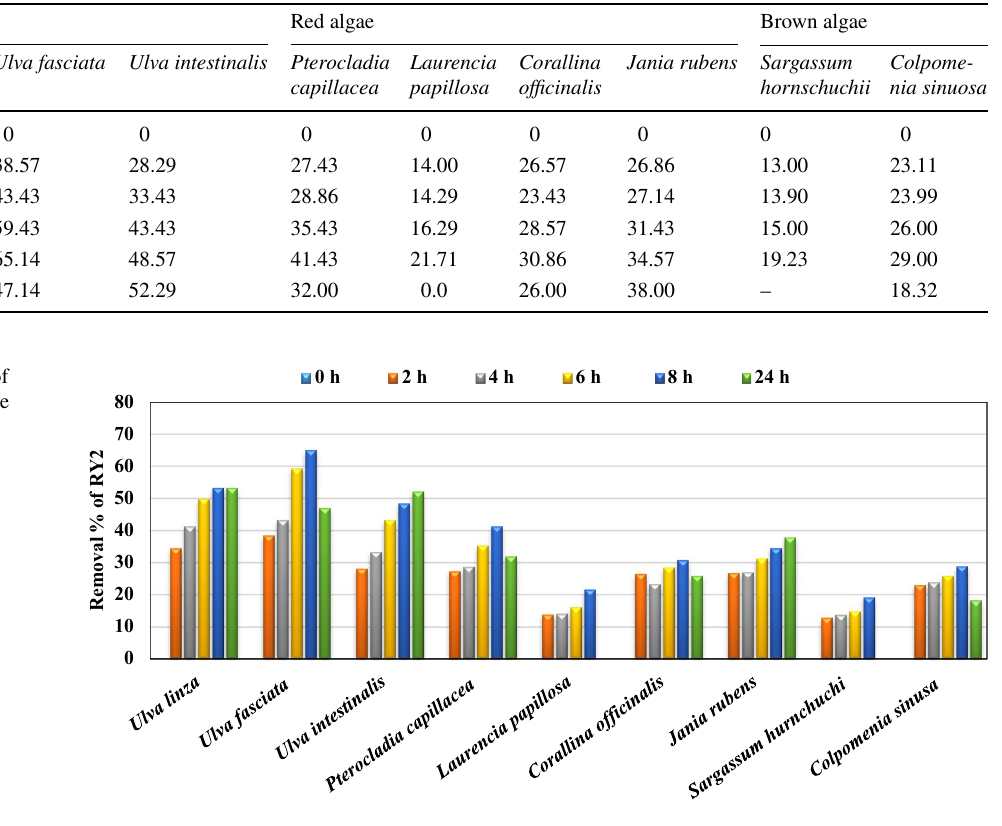
Table 7 Removal percentage of Reactive Yellow 2 (RY2) by the nine studied dried algal species Removal % of RY2 (λmax = 404 nm) Algae